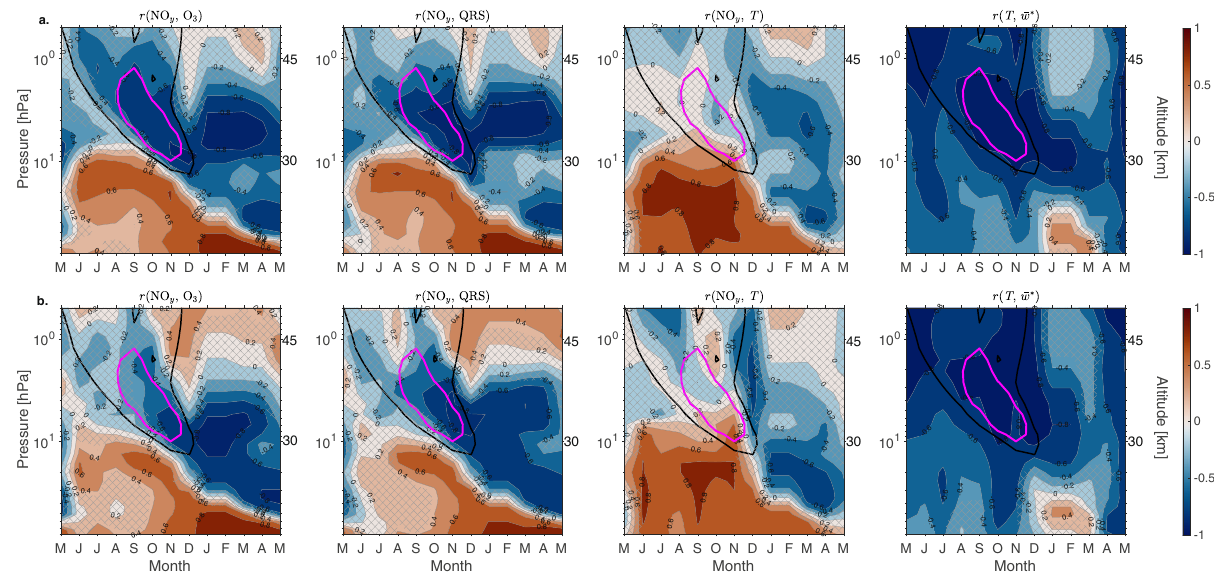
Fig. 4 | Connection between chemistry and dynamics. Correlation of monthly meanpolarcap nitrogenfamily,NO y (NO x ,HNO 3 ,N 2 O 5 , ClONO 2 ,HNO 4 )andozone (O 3 ), shortwave heating rate (QRS), temperature ( T ) anomalies for ( a. ). High ener- getic particle precipitation (EPP) years, and ( b. ) Low EPP years. Last panels shows the correlation between temperature and w * anomalies. Hatching indicates areas not statistically signi fi cant at 95% level ( p >0.05). NO y differences of 0.001 ppmv